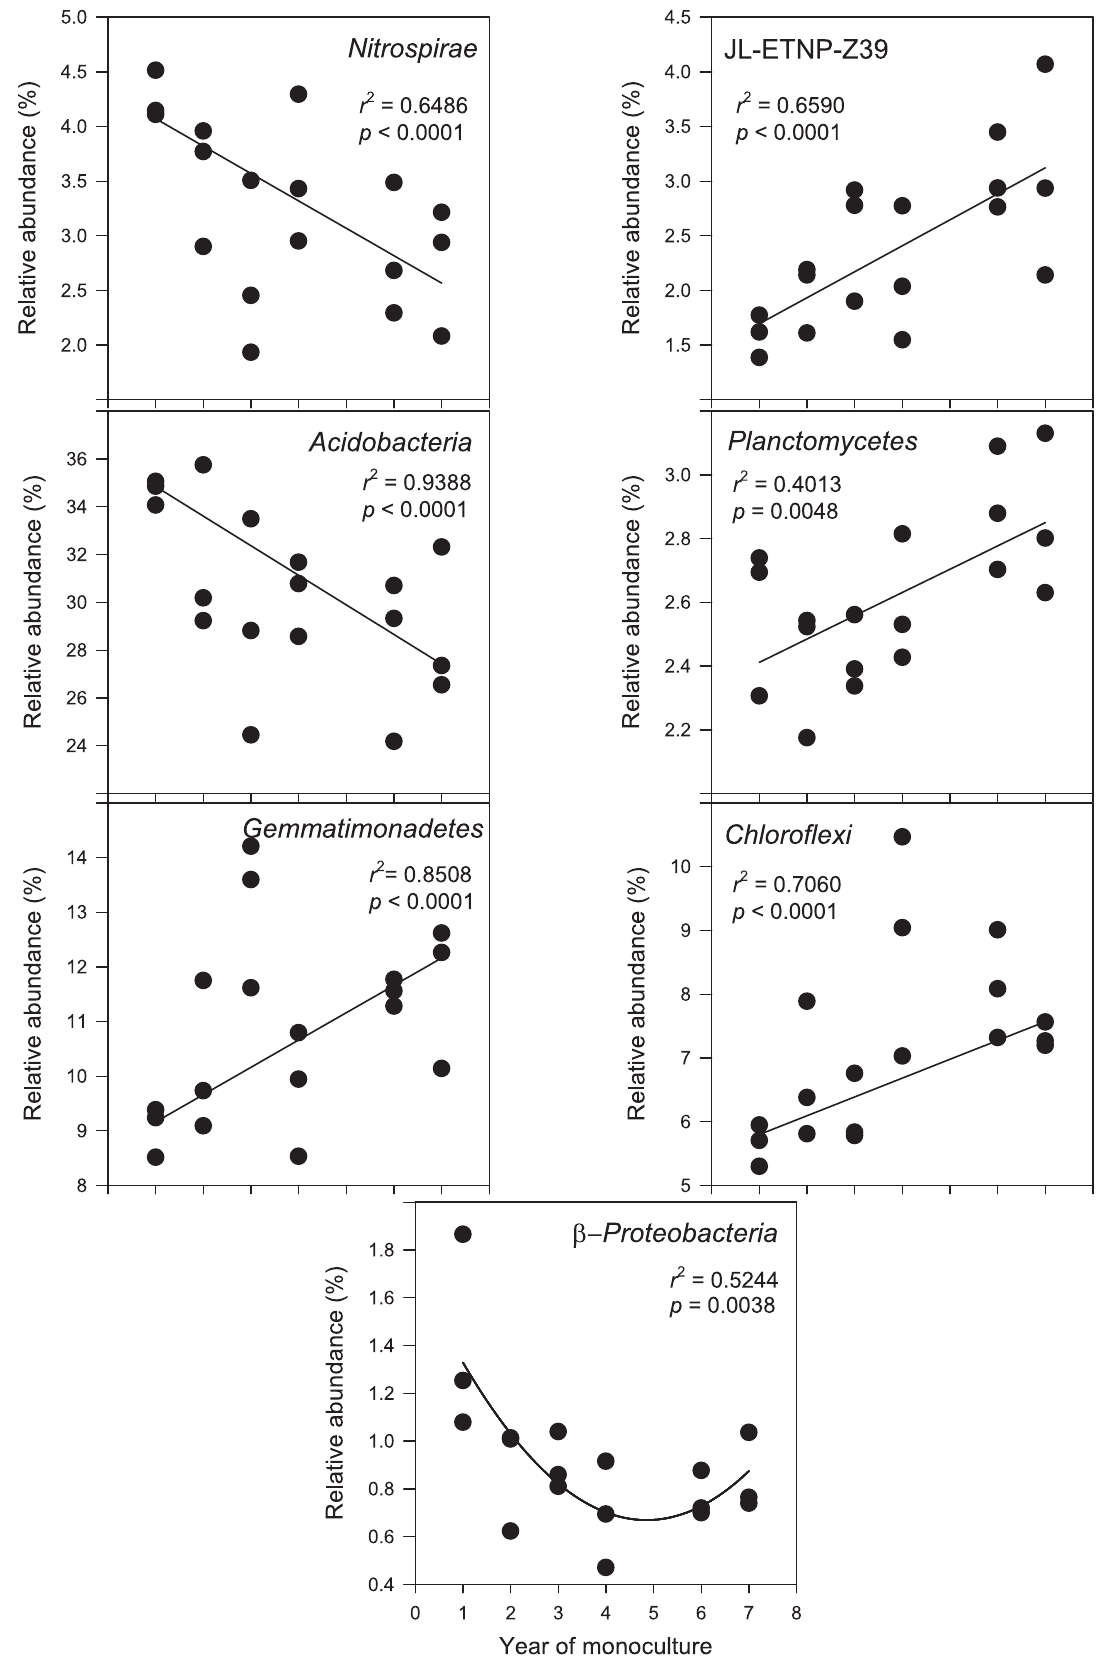
Figure 4. Regressions between bacterial taxa abundances and the year of potato monoculture. doi:10.1371/journal.pone.0086610.g004 PLOS ONE |